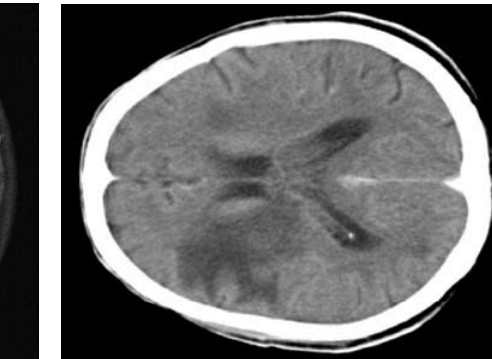
Fig. 3. Follow-up CT 2 months later demonstrates significant progression of the